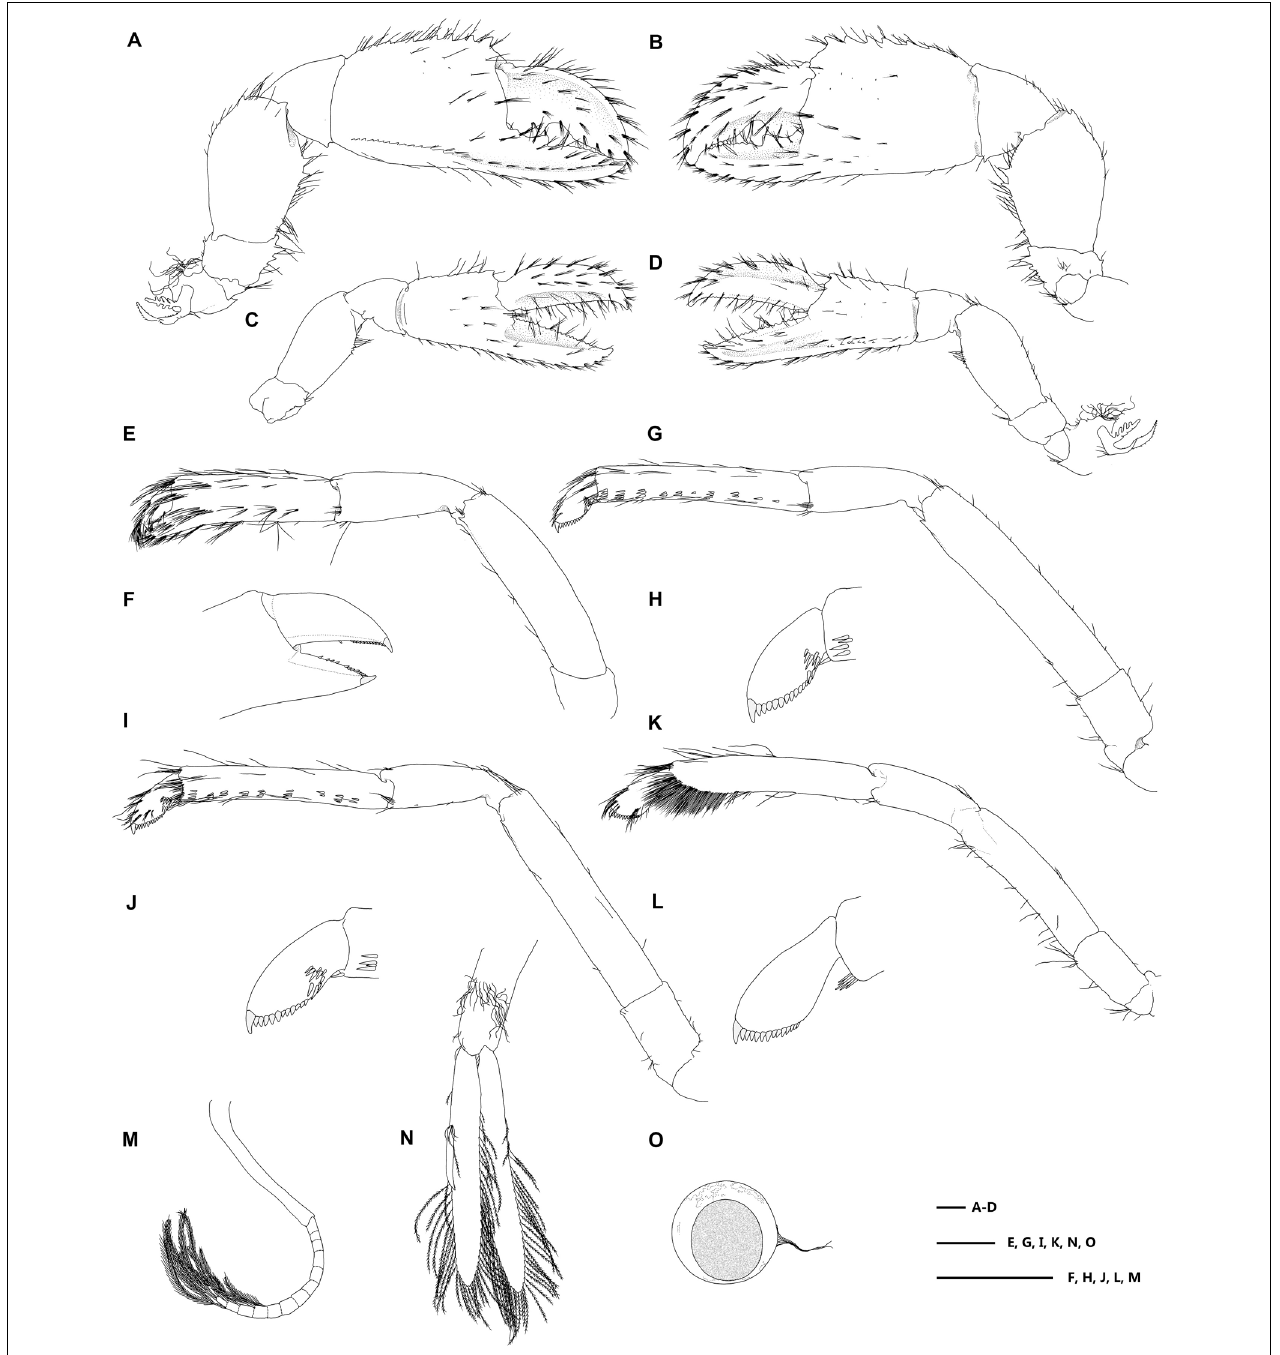
FIGURE 4 | Eiconaxius serratus sp. nov. Holotype, SRSIO 14070301 (ovigerous female, cl 9.0 mm). (A) major cheliped, right, lateral view; (B) same, inner view; (C) minor cheliped, left, inner view; (D) same, lateral view; (E) pereopod 2, left, lateral view; (F) same, fingers, mesial view; (G) pereopod 3, left, lateral view; (H) same, dactylus, lateral view; (I) pereopod 4, left, lateral view; (J) same, dactylus, lateral view; (K) pereopod 5, left, lateral view; (L) same, dactylus, lateral view; (M) pleopod 1, right; (N) pleopod 2, right; (O) egg, with ovipositing setae. Scales: 1 mm.